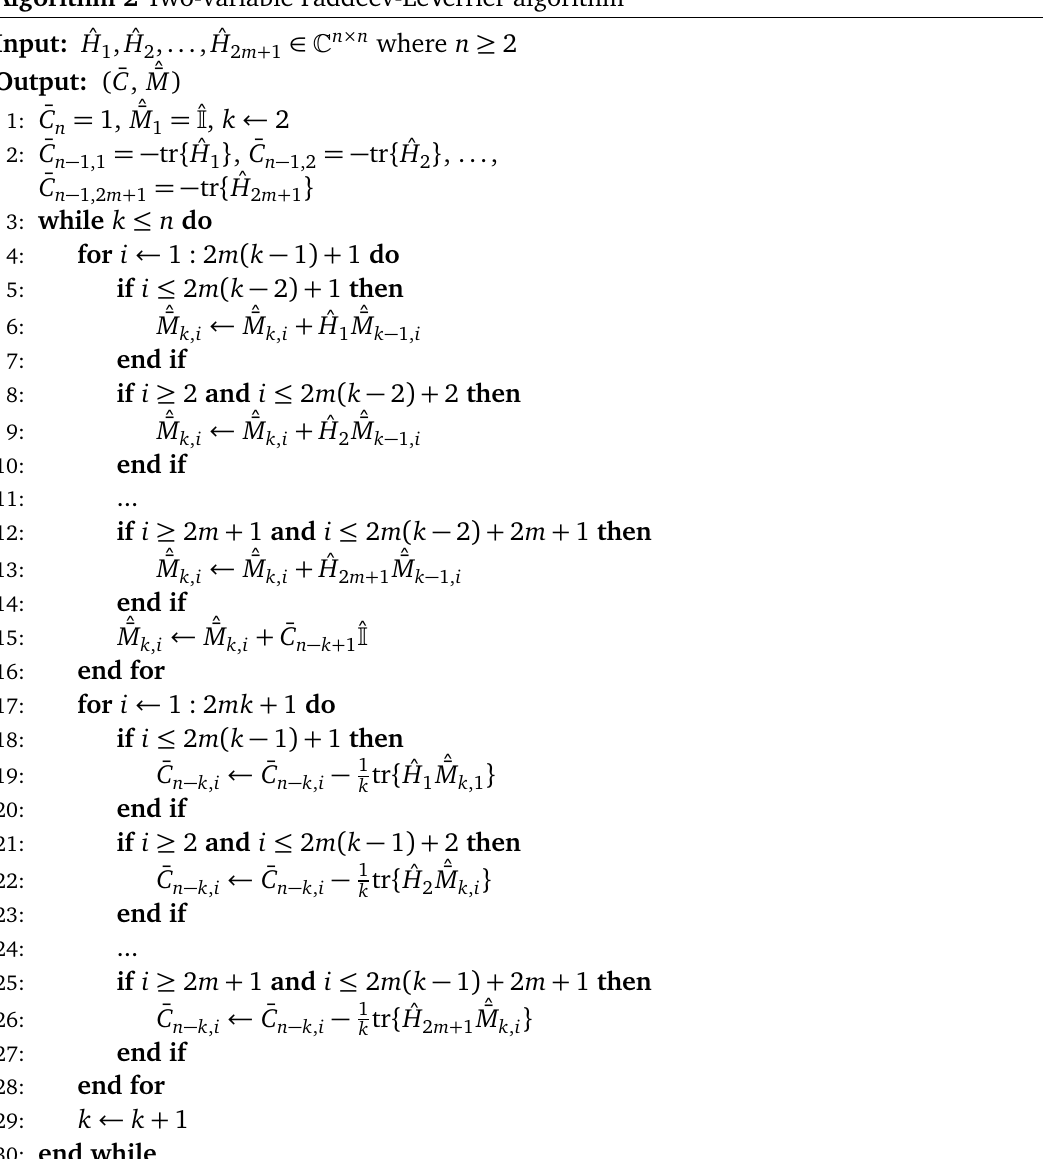
Algorithm 2 Two-variable Faddeev-LeVerrier